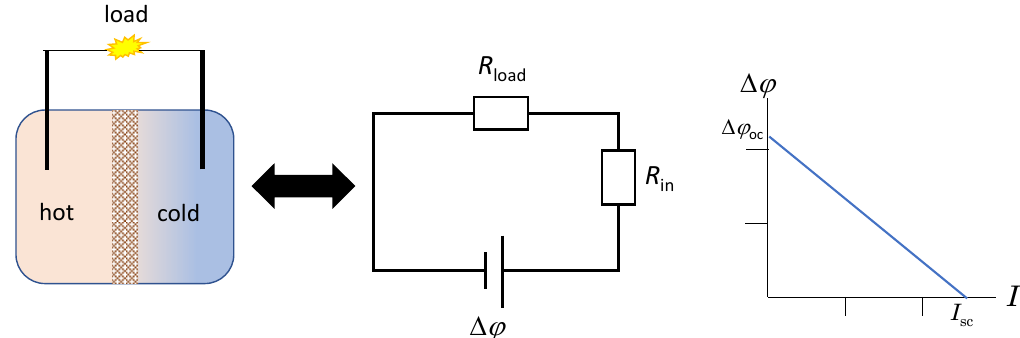
Figure 2. Sketch of a basic membrane-based thermocell and equivalent circuit (on the left), and characteristic ∆ ϕ - I curve (on the right). ∆ ϕ : Output voltage; R in : Internal resistance; R load : Load resistance; ∆ ϕ oc : Open-circuit voltage; I sc : Short-circuit current.